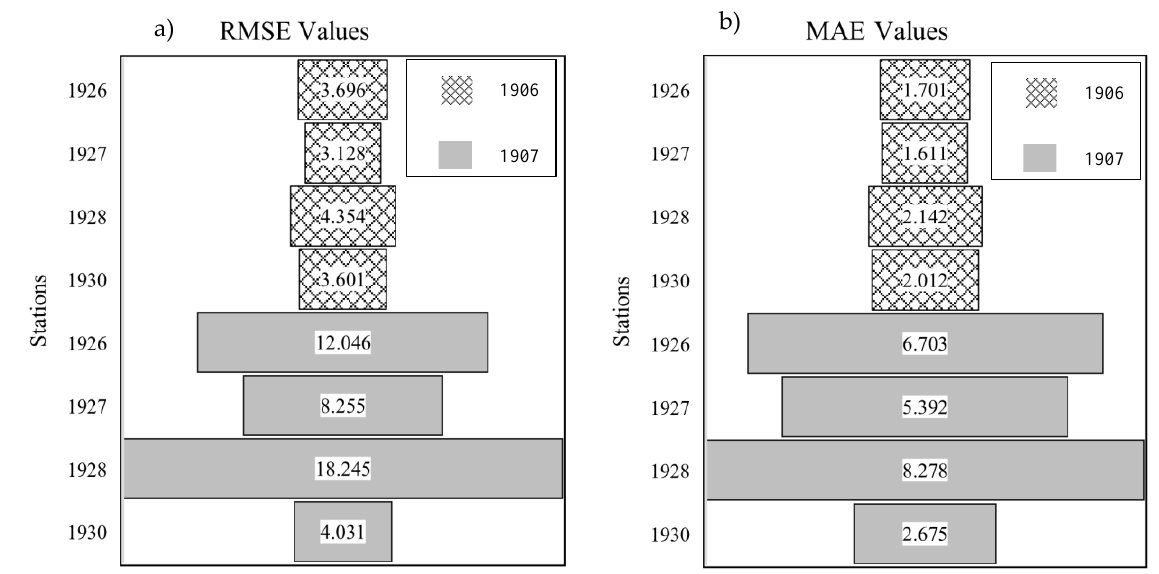
Figure 6. Correlation plot between the original and bias-corrected values for the number 1906 and 1907 SGSs. (a) 1926 to 1906, (b)1927 to 1906, (c) 1928 to 1906, (d) 1930 to 1906, (e) 1926 to 1907, (f)1927 to 1907, (g) 1928 to 1907, (h) 1930 to 1907. Linear regression line represented with grey, x=y graph represented with black colored line.